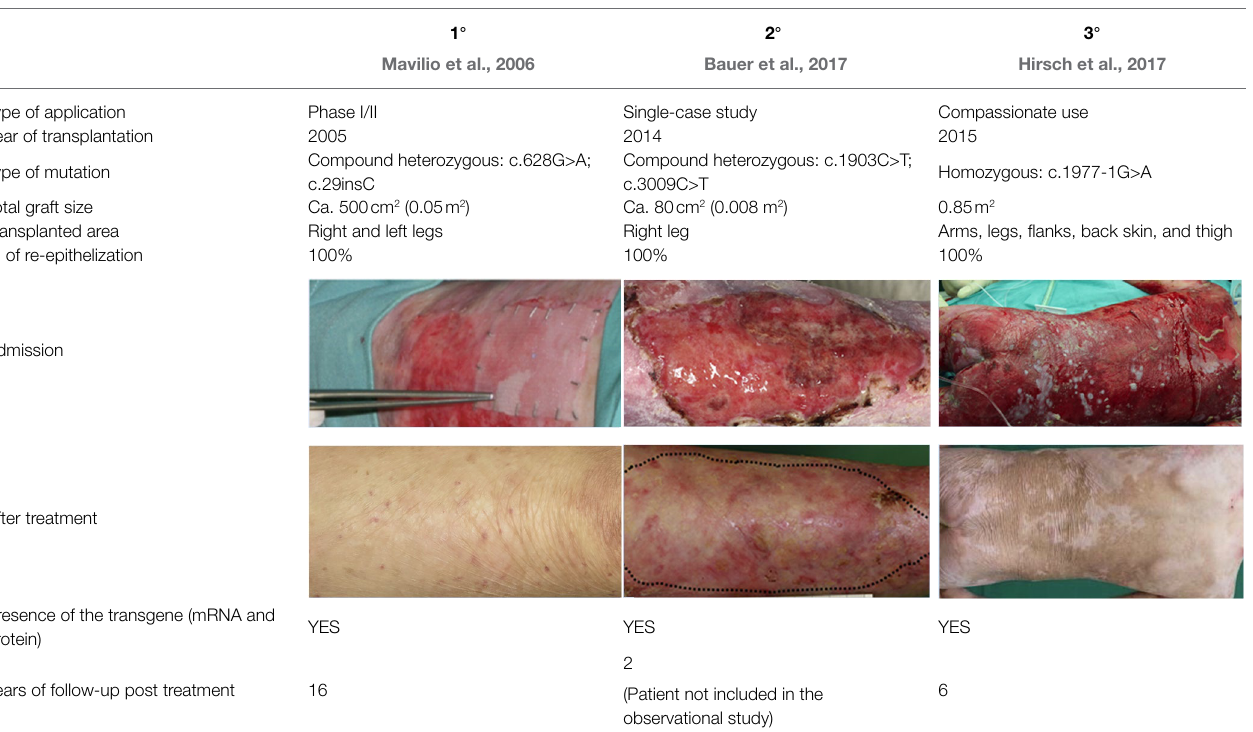
TABLE 1 | Summary of clinical data on previously treated